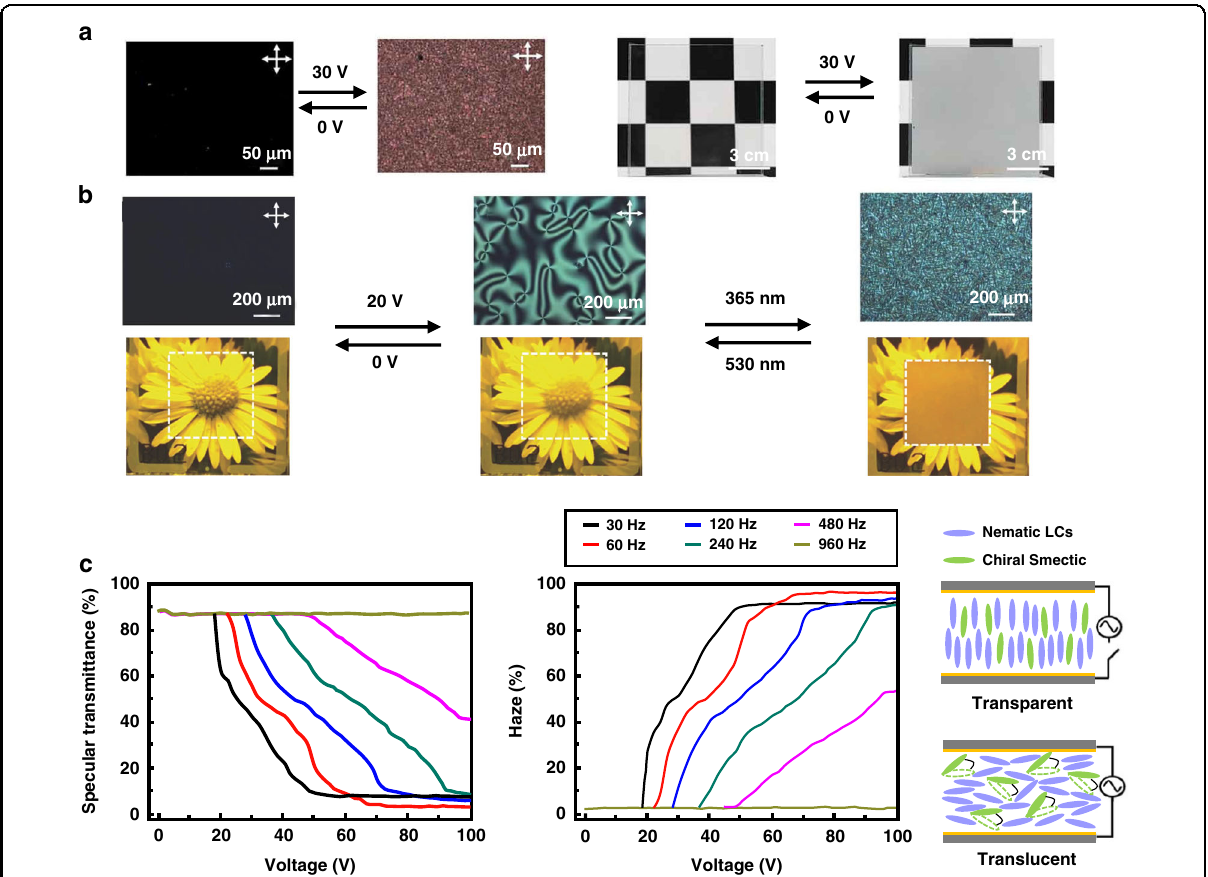
Fig. 11 Switchable optical devices based on dynamic scattering principle. a smart window fabricated using the EHDI effect. Reproduced with permission from ref. 149 . Copyright 2020, Taylor & Francis Group. b Light-induced EHDI devices obtained by doping LCs with a photochromic dye. Reproduced with permission from ref. 150 . Copyright 2018, Wiley Online Library. c An LC smart window device based on the EHDI effect without ion